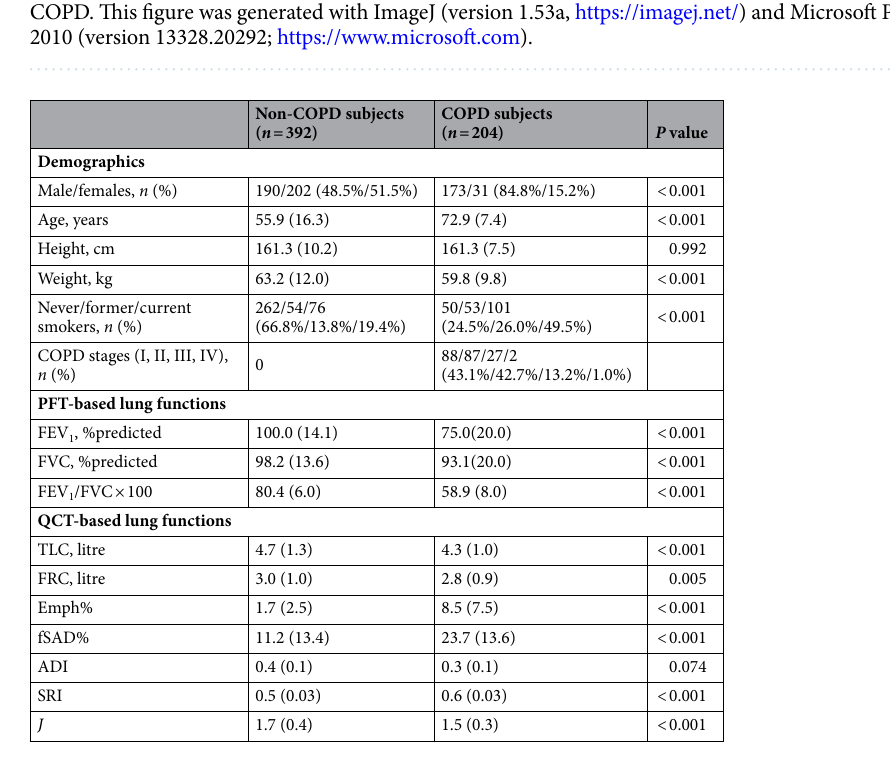
Table 1. Demographics and lung functions derived from the PFTs and QCTs of COPD and non-COPD subjects. Values are presented as mean (SD). QCT, quantitative computed tomography; PFT, pulmonary function test; FVC, forced vital capacity; FEV 1 , forced expiratory volume in 1 s; FRC, functional residual volume; TLC, total lung capacity; Emph%, percent emphysema; fSAD%, percent functional small-airway disease; ADI, anisotropic deformation index; SRI, slab rod index; J ,